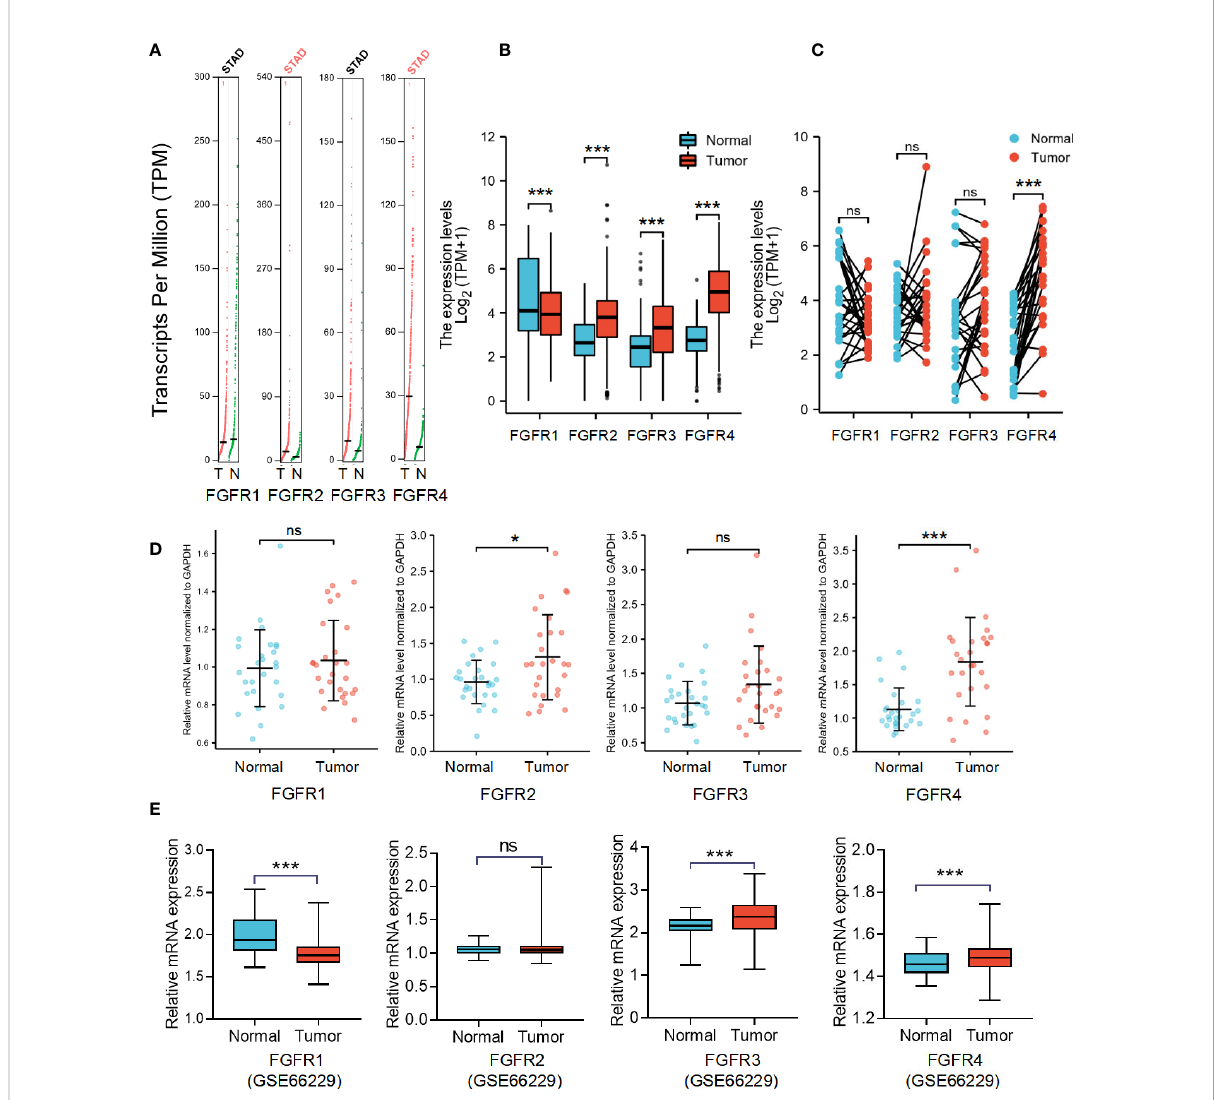
FIGURE 1 The mRNA expression levels of FGFRs in GC. (A) The differential expression of FGFR family members in cohort tumor and non-tumor tissues was analyzed with GEPIA. (B) The difference in expression of FGFRs between STAD in TCGA data sets and normal gastric tissues in GTEX data sets. (C) The differences in expression of FGFRs between STAD and matched normal tissues from TCGA-STAD database were determined by GEPIA. (D) The mRNA expression of FGFRs in gastric tumor tissues and matched adjacent non-tumor tissues from our samples. (E) The differential expression of FGFRs between tumor and matched normal tissues from GSE66229 database. *p < 0.05; ***p < 0.001; **** p <0.0001; ns, not signi fi cant; GC, gastric cancer; T, tumor; N,